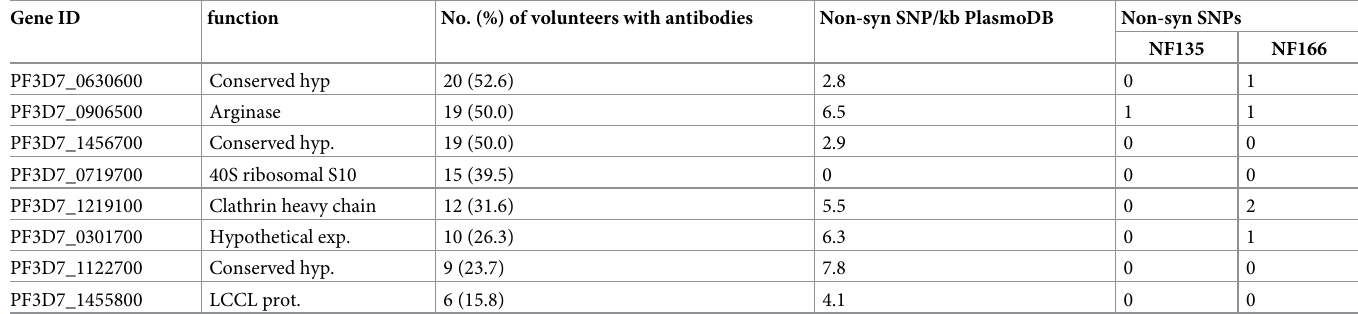
Table 2. Putative markers of exposure to sporozoites. Genes selected by the greedy method to cover all volunteers with their gene ID, function and number of volun- teers with antibodies after CPS immunization as reported by Obiero et al . [13]. The non-synonymous SNPs are given as a proxy for genetic variability, with PlasmoDB and two sequenced laboratory strains as